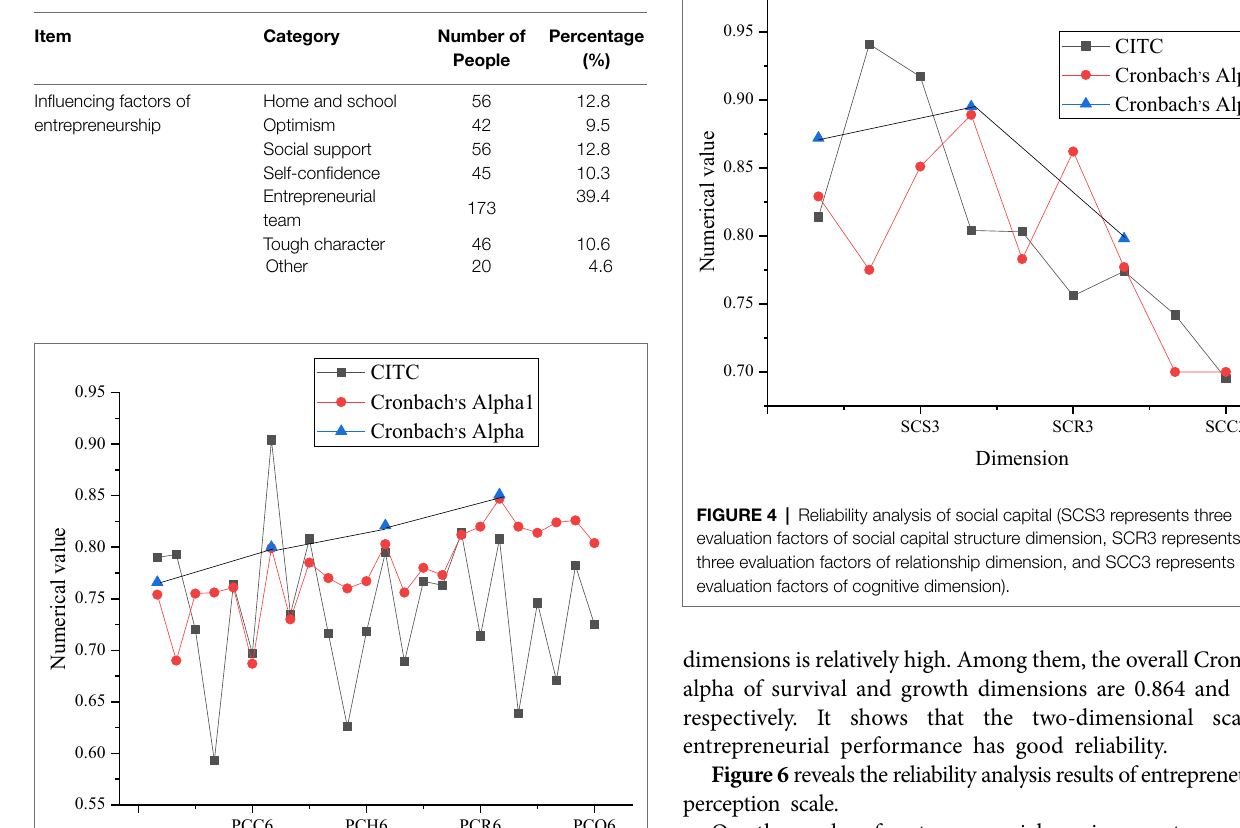
Figure 4 denotes the results of social capital reliability analysis.